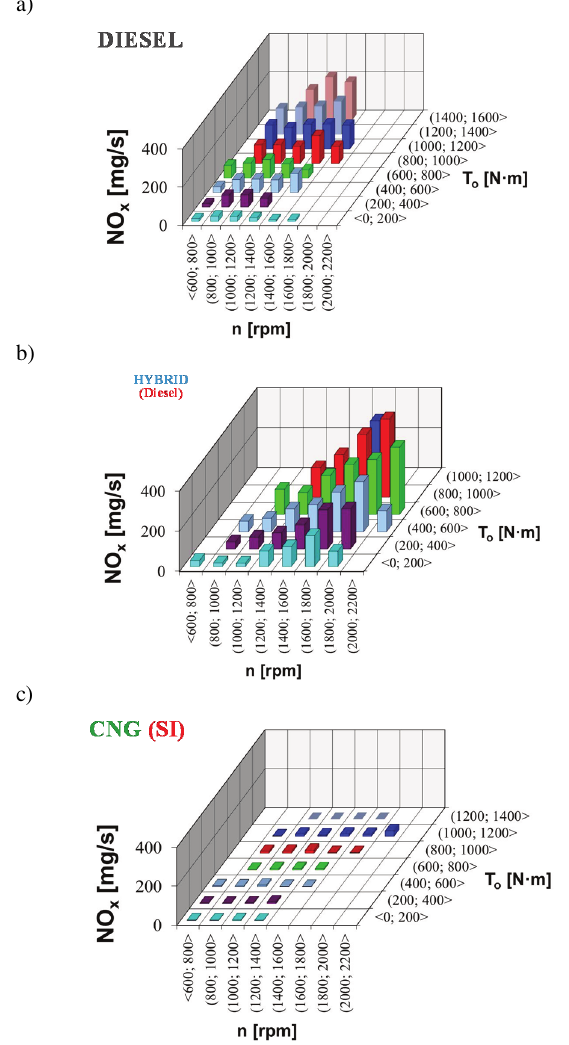
Fig. 27. Carbon monoxide emission intensity in road tests: a) bus with a diesel engine, b) hybrid bus, c) bus powered by natural gas